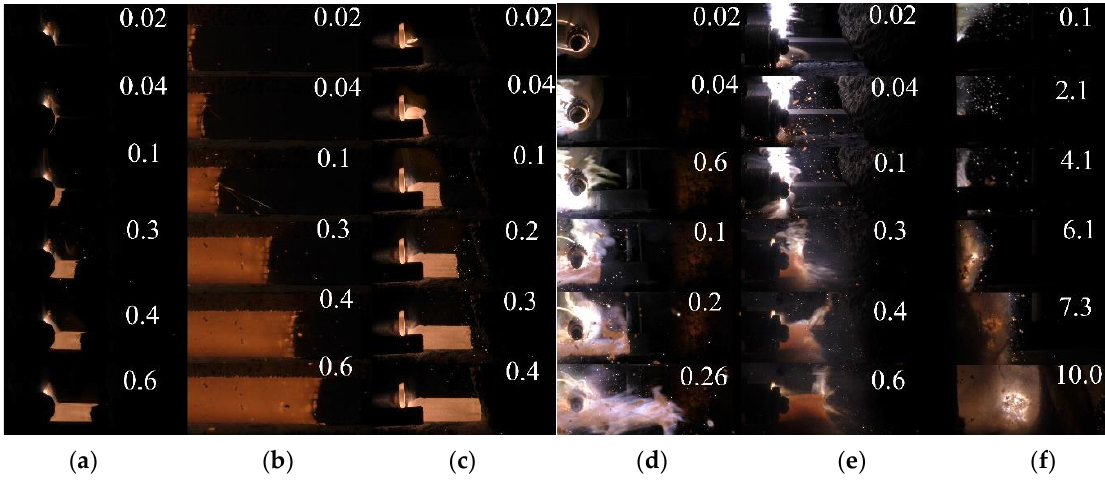
Figure 15. Video frames of combustion in the Ni – Al system (time is given in seconds): ( a ) unreinforced; ( b ) with boron fibers; ( c ) with tungsten fibers; ( d ) with 1 wt % PTFE; ( e ) with 3 wt % PTFE; ( f ) with 15 wt % PTFE.